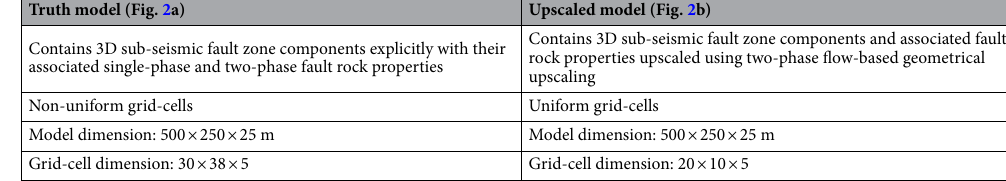
Table 1. The geometrical structure, volume of interest (i.e., model dimension), and grid-cell dimension of the models.